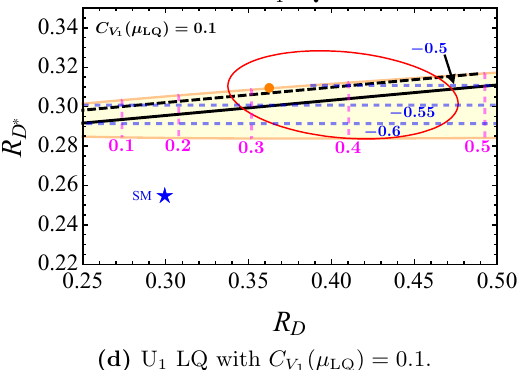
Figure 3. The contours of the (cid:28) polarizations P D and P D (cid:3) are shown on the R D { R D (cid:3) plane in (cid:28) (cid:28) magenta and blue colors, respectively, when we consider the LQ scenarios of (a) R 2 , (b) S 1 with C V = 0, (c) S 1 with C V = 0 : 1 and (d) U 1 with C V = 0 : 1. In all cases, m LQ = 1 : 5 TeV is taken. 1 1 1 The SM point is represented by the blue